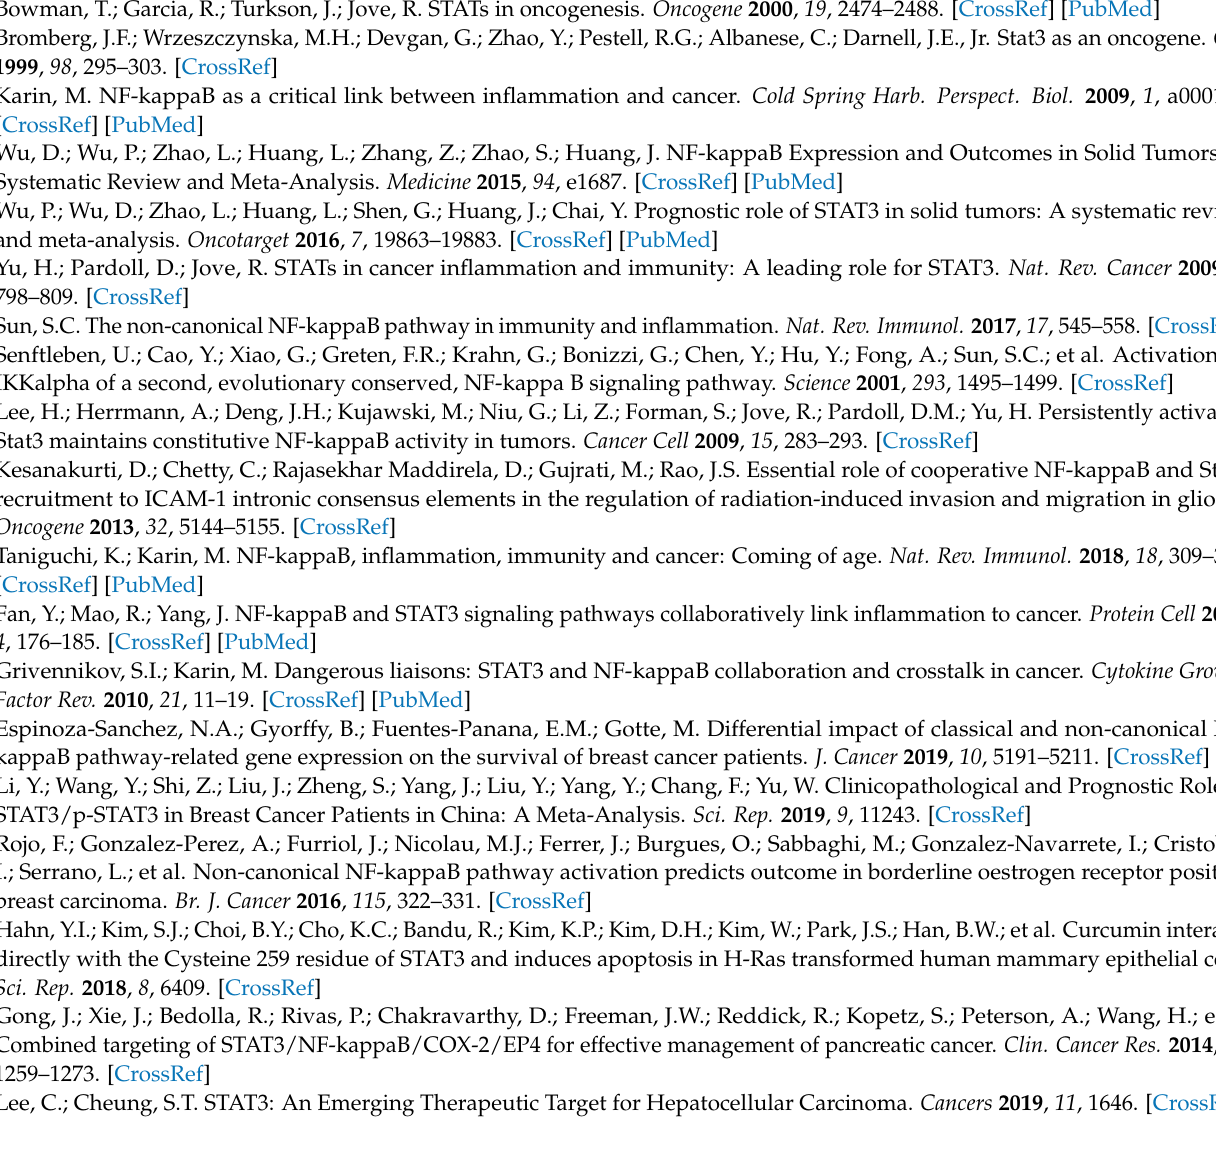
The original blot images of Figure 4C,D; Figure S12: The original blot images of Figure 5; Figure S13: The original blot images of Figures S1 and